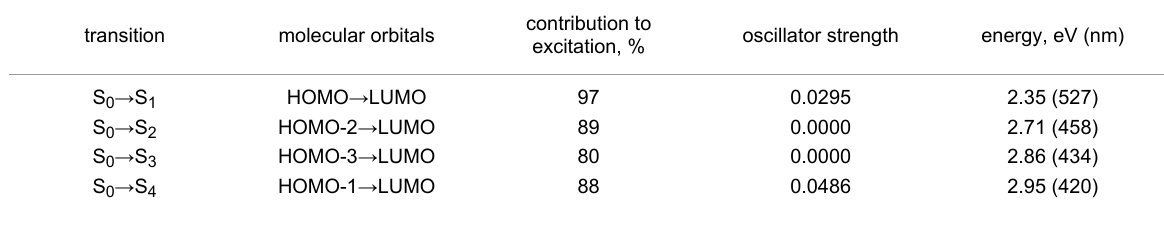
Table 3: Calculated transitions for 8a , showing only the main contribution to each excitation. Calculated using TD-B3LYP/6-311+G(d,p)//B3LYP/6-